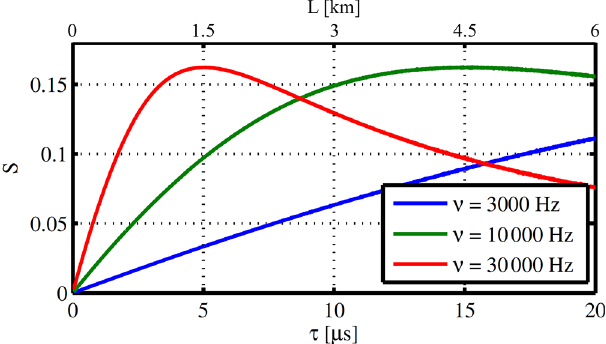
Figure 9. Sensitivity S(τ) (Eq. 6) of the demonstration setup (Sect. 5.1, quasi-rectangular I(t) and (cid:50)(t) profile) for three dif- ferent modulation frequencies ν . At ν = 3kHz, S increases nearly linearly with decay time in the investigated path length range. At higher ν there are optimal sensitivities at certain decay times. ν S in the expected path length